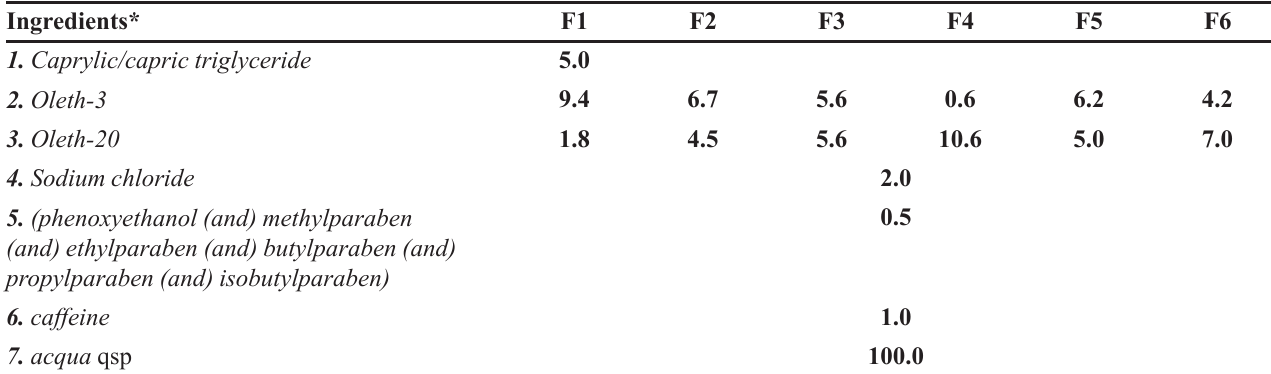
TABLE I - Qualitative and quantitative composition (% w/w) of the preparations ( 1 to 6 )